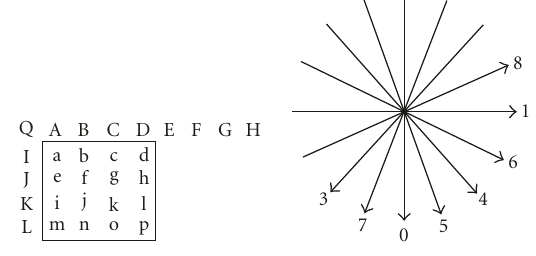
Figure 5: (a) Neighboring samples “A-Q” are used for prediction of samples “a-p.” (b) Prediction mode directions (except DC